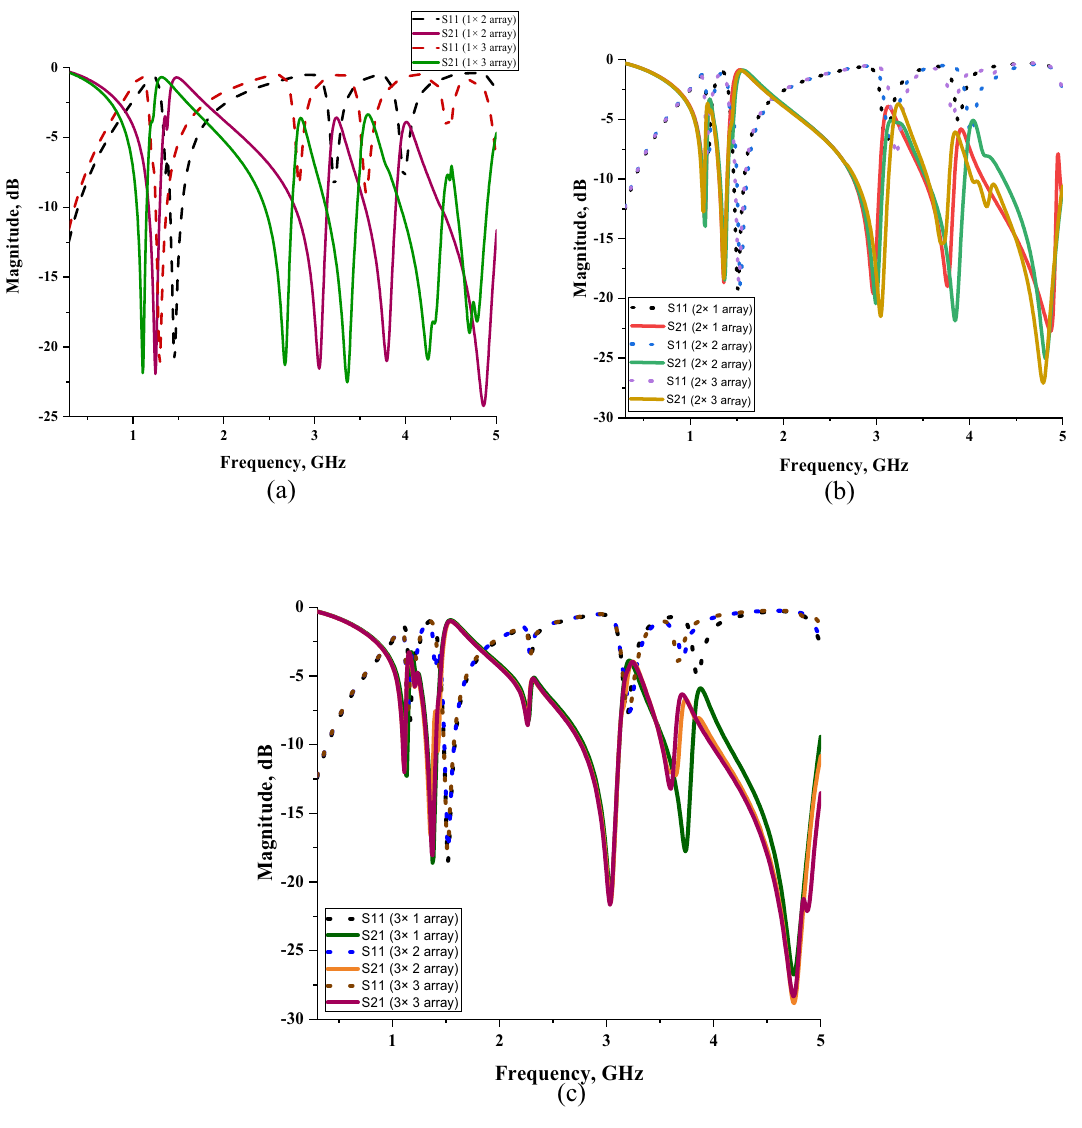
Figure 7. Comparison of reflection and transmission coefficient results of array metamaterials of: ( a ) one number row, ( b ) two number rows, ( c ) three number